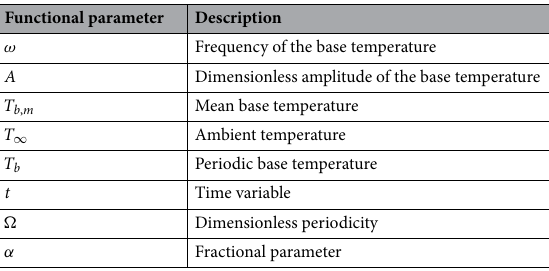
Table 1. Functional and rheological